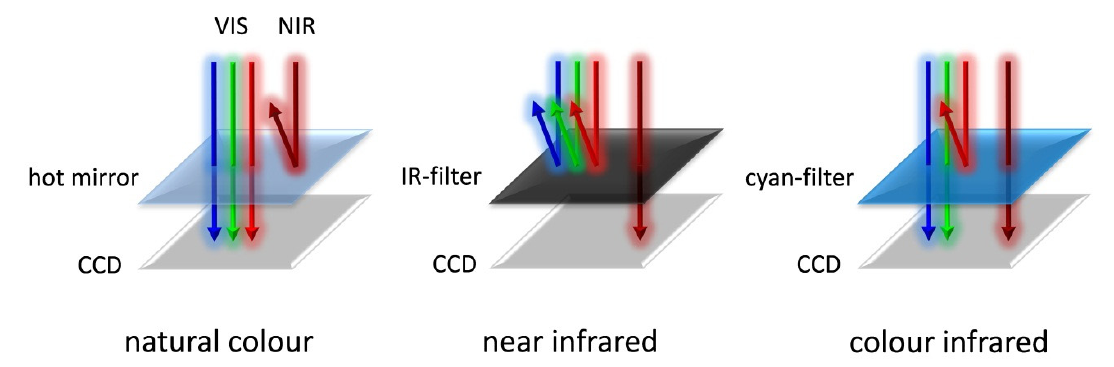
Figure 3. The effect of different optical filters to the spectral recording of the cameras charge coupled device (CCD) mounted to the UAS in order to obtain true colour (VIS = visible), near infrared (NIR = infrared) or modified colour infrared (CIR) images. In this study visible red instead of visible blue was blocked by the cyan filter in order to extract the pure NIR